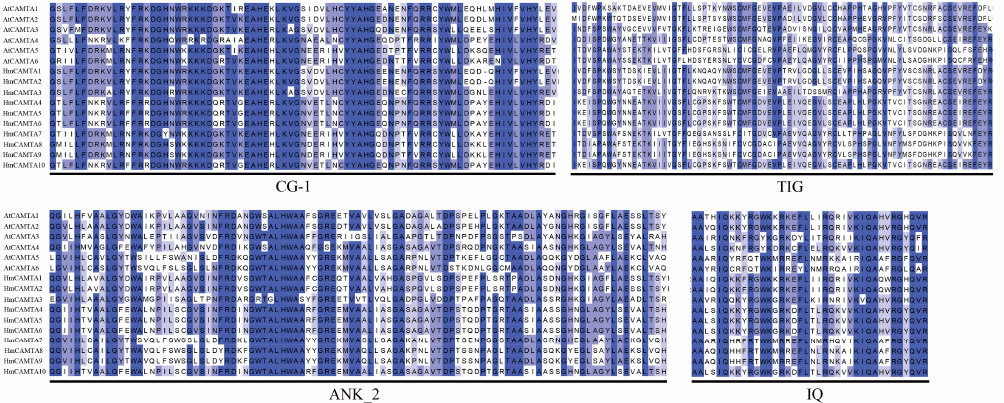
Figure 4. Amino acid sequence alignment of A. thaliana and H. myrtifolia . The black box lines represent the four domains of HmCAMTA.